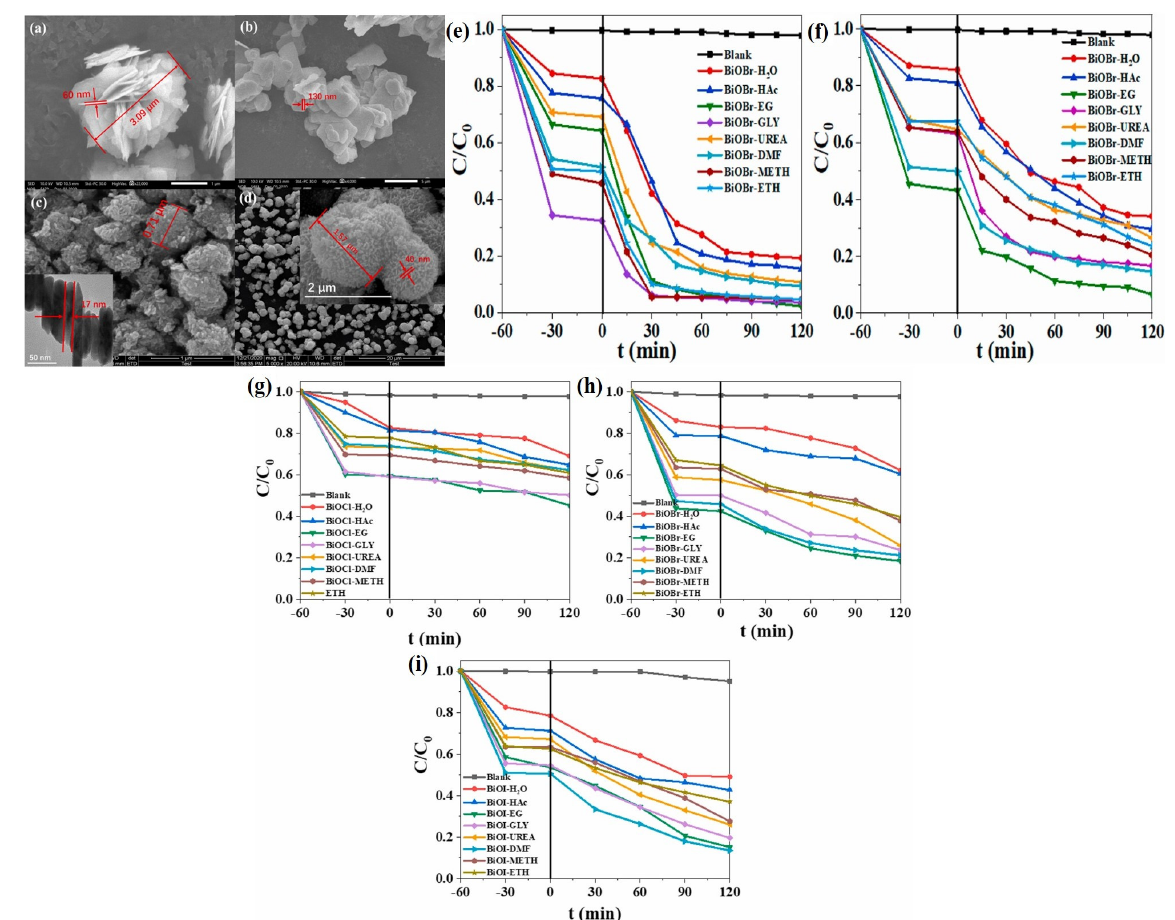
Figure 9. SEM graphs of ( a ) BiOBr, ( b ) BiOI synthesized using water, ( c ) BiOBr, ( d ) BiOI prepared using ethylene glycol, ( e ) photocatalytic behavior of BiOBr over tetracycline in the presence of simulated sunlight, ( f ) under visible light; ( g ) photocatalytic behavior of BiOCl ( h ) BiOBr and ( i ) BiOI over methyl orange dye under visible light. Reproduced with permission [124], Copyright 2021, Elsevier.